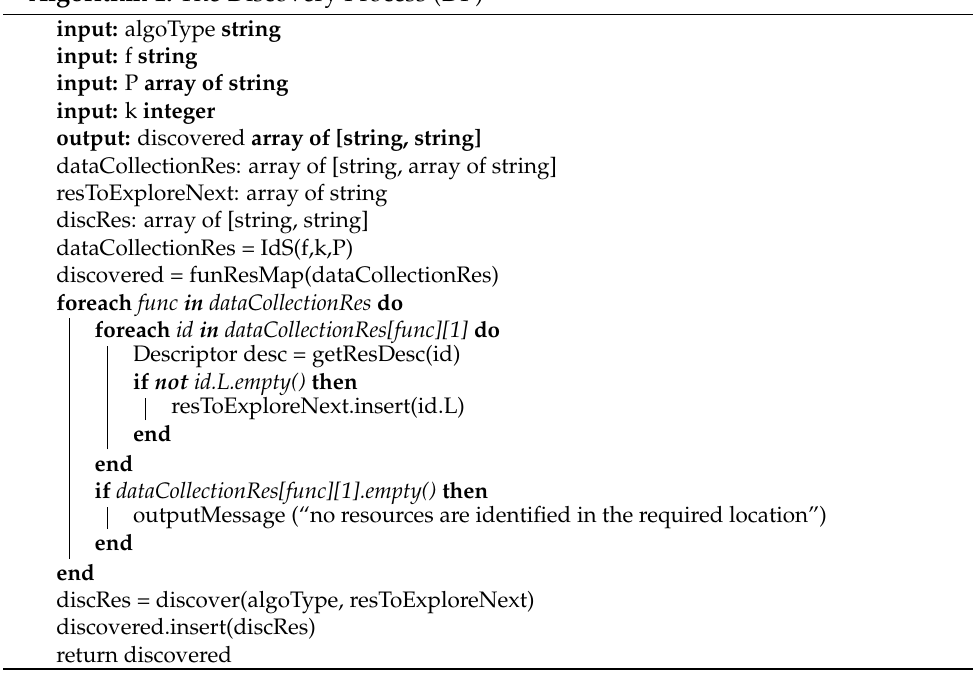
Algorithm 1: The Discovery Process